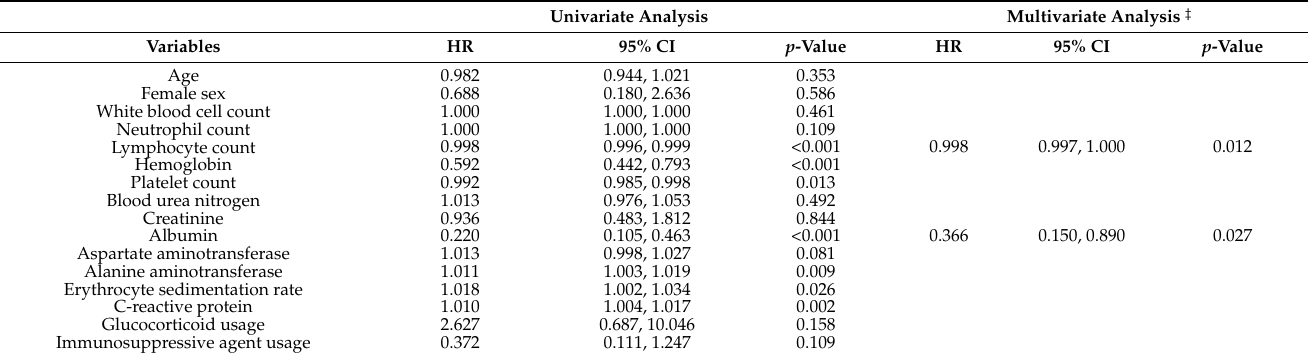
Table 5. Logistic regression analysis for factors associated with indeterminate